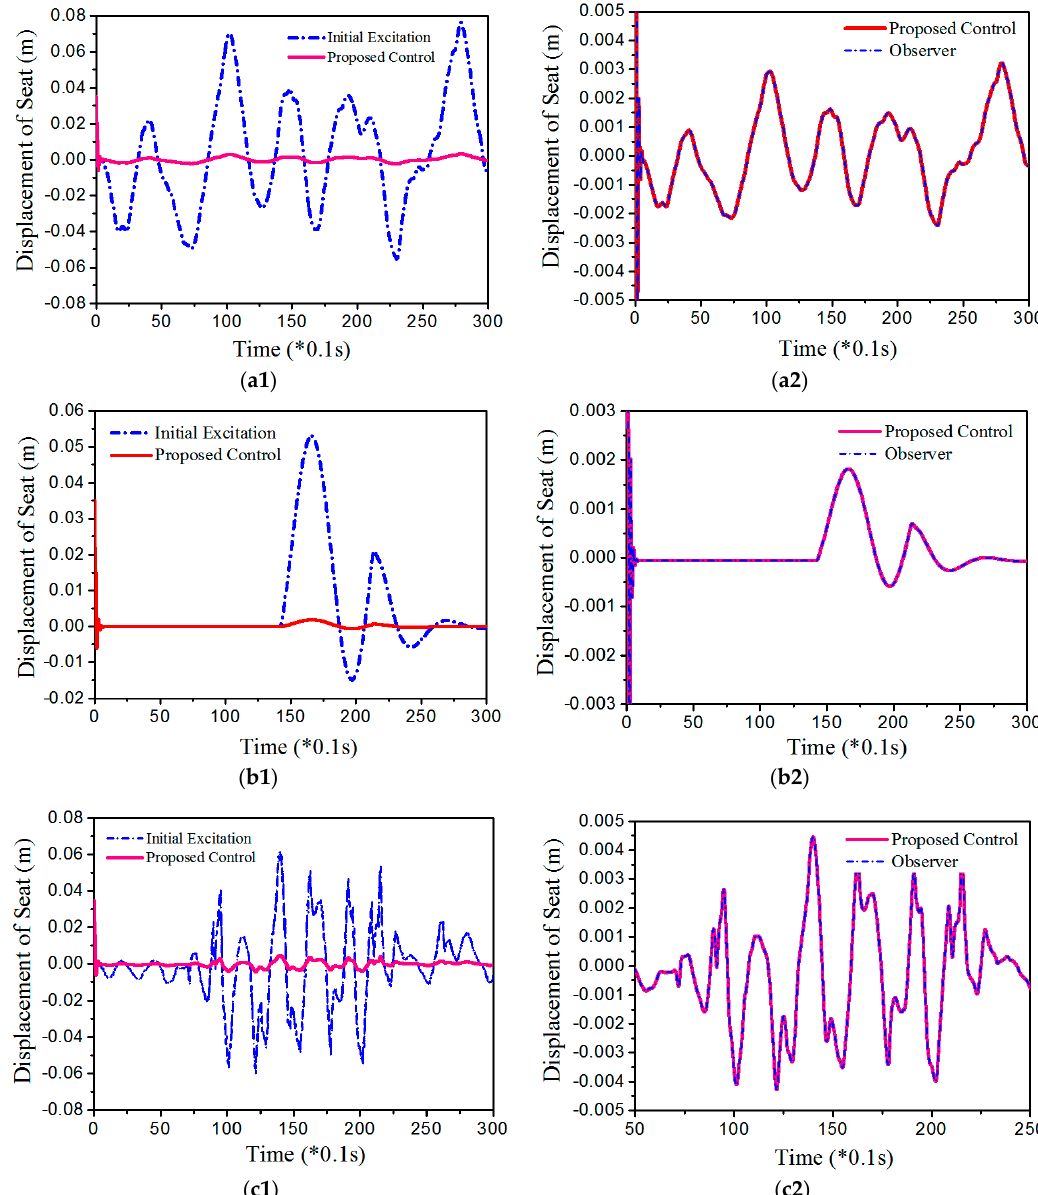
Figure 4. Simulation results of the displacement x s of the seat: ( a1 , a2 ) random-bump road; ( b1 , b2 ) regular-bump road; ( c1 , c2 ) random step wave road .